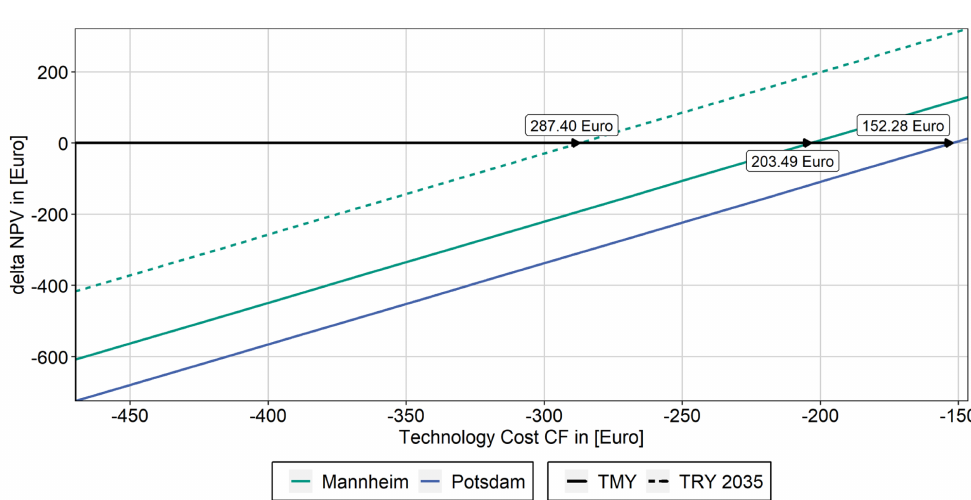
Figure 10. ∆ NPV sensitivity to costs changes.